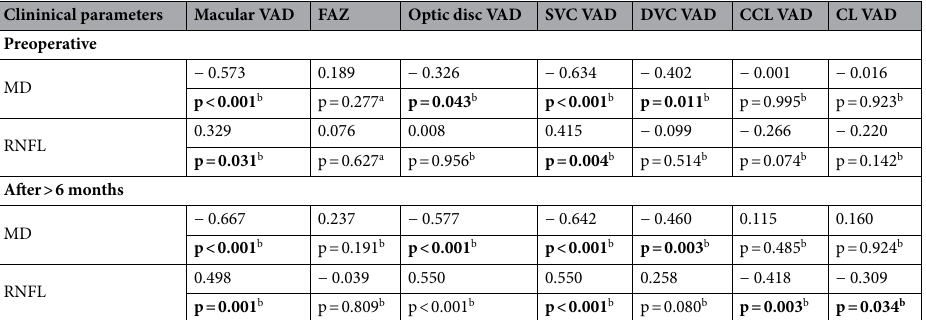
Table 4. Correlation analysis. Significant values are in bold. MD mean deviation, RNFL retinal nerve fiber layer thickness, VAD vessel area density, FAZ foveal avascular zone, SVC superficial vessel complex DVC deep vessel complex, CCL choriocapillaris layer, CL Chorioideal layer. a Spearman. b Pearson. All values are shown as correlation coefficient and p value.